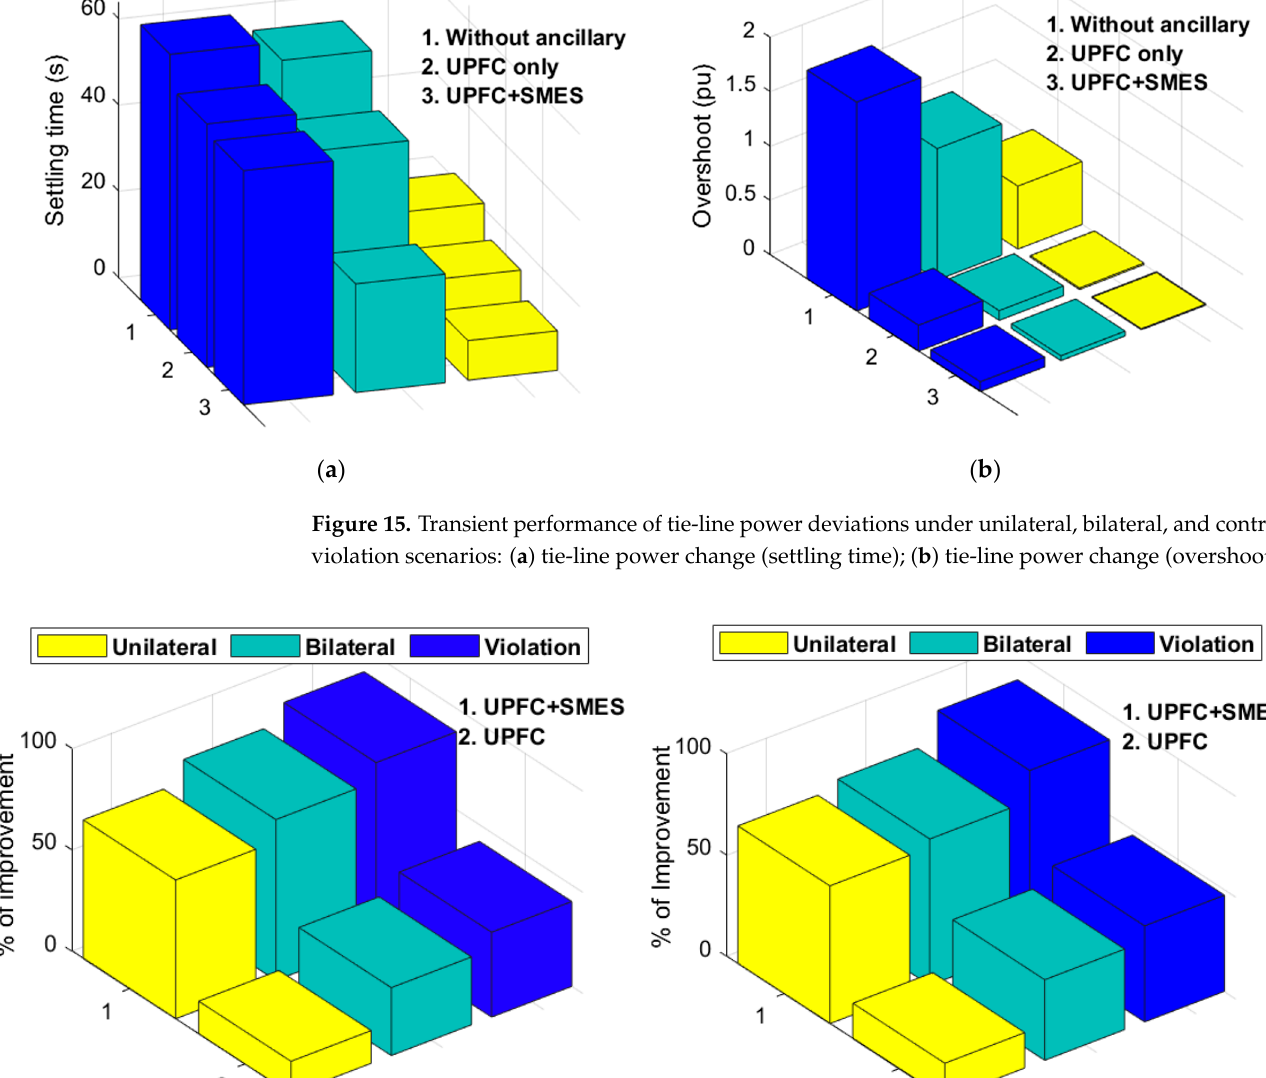
Figure 14. Transient response of frequency deviations in unilateral, bilateral, and contract violation scenarios: ( a ) frequency deviation in area-1 (setting time); ( b ) frequency deviation in area-2 (setting